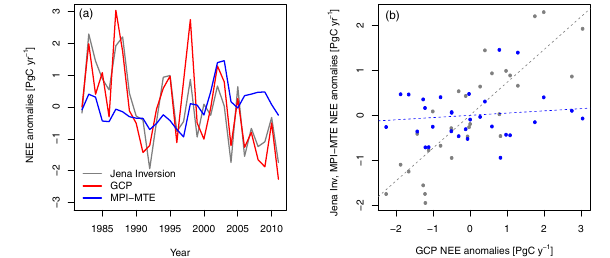
Figure 11. Comparison of the annual NEE anomalies between the Jena Inversion, MPI-MTE and the Global Carbon Project data. Time series of annual anomalies are shown in (a) , while regressions of MPI-MTE and the Jena Inversion values are shown in (b) versus annual anomalies of the Global Carbon Project